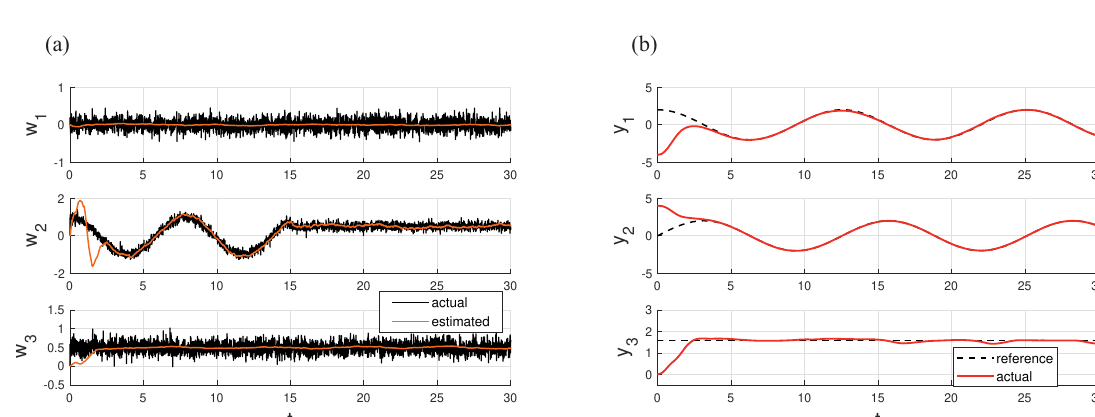
Figure 3. (a) The disturbance estimation results for the U-Cat model; (b) The output trajectories of the U-Cat model in the case when continuous disturbance estimate signal is sent to the controller.